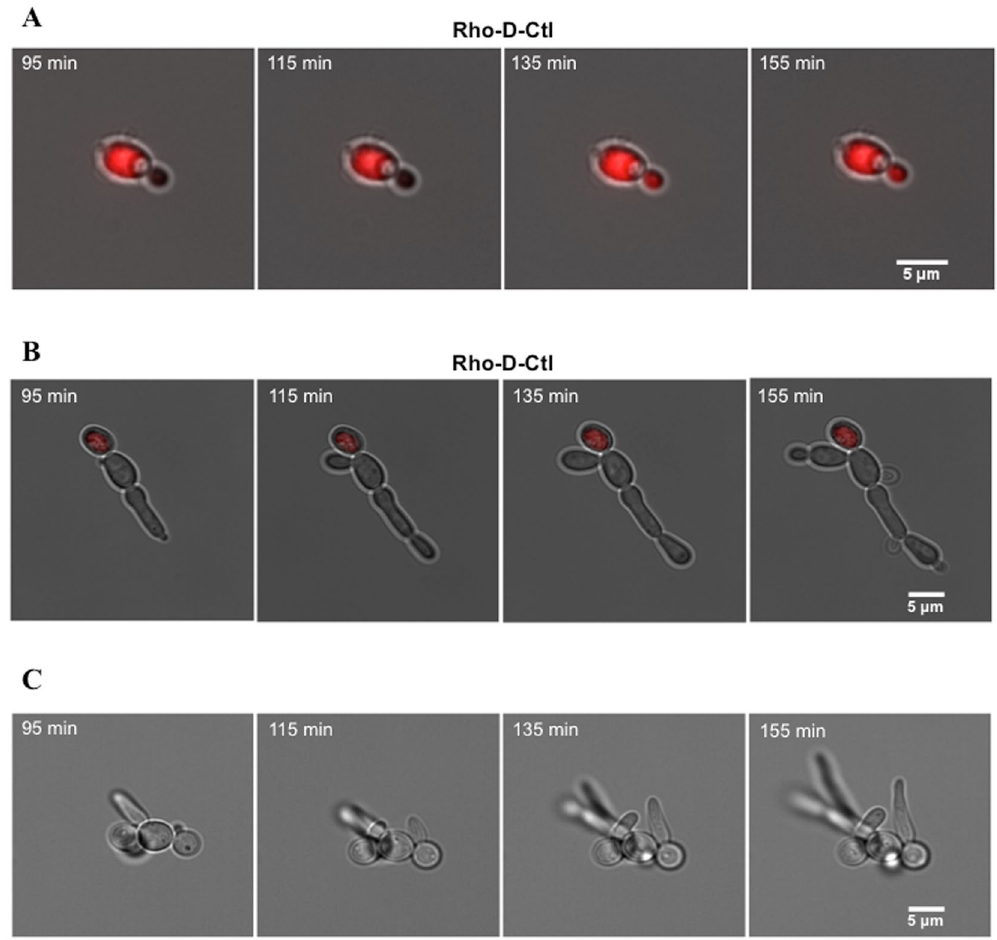
Figure 4. Time-lapse video microscopy of Candida albicans colonies treated with Rho-D-Ctl. Candida albicans was incubated for 30 min at 37 °C with Rho-D-Ctl at 10 × MIC (55 μ g/mL). Cells were then washed and the interaction between Candida albicans and D-Ctl was followed by video microscopy. Images (fluorescence and phase contrast) were captured with a 60X objective. The time elapsed between two frames is 20